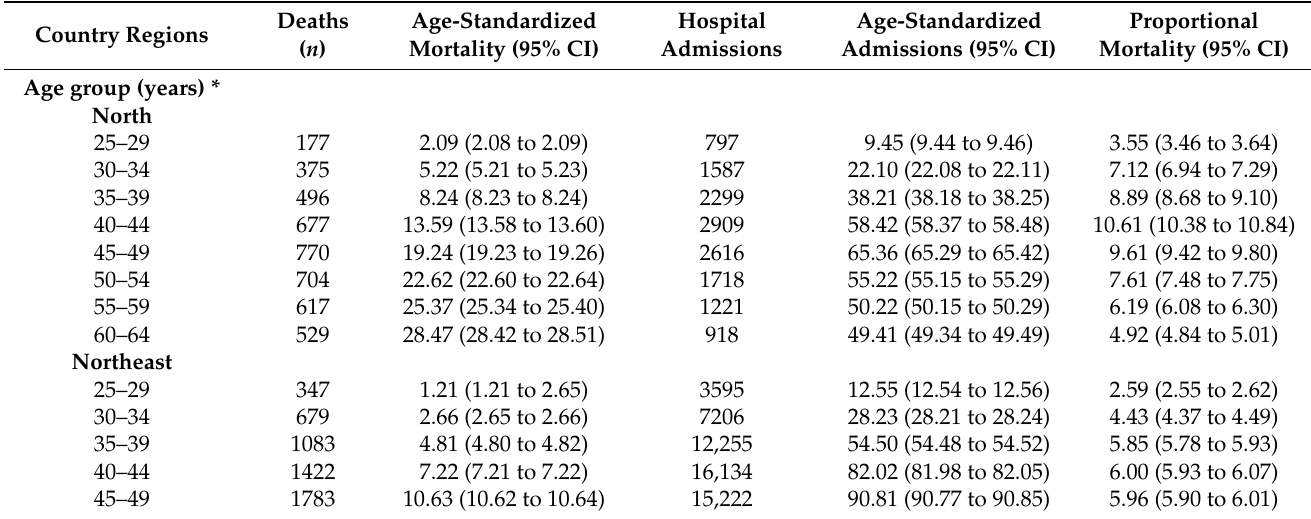
Table 1. Loading cervical cancer † in Brazilian women aged 25 to 64 during. Country